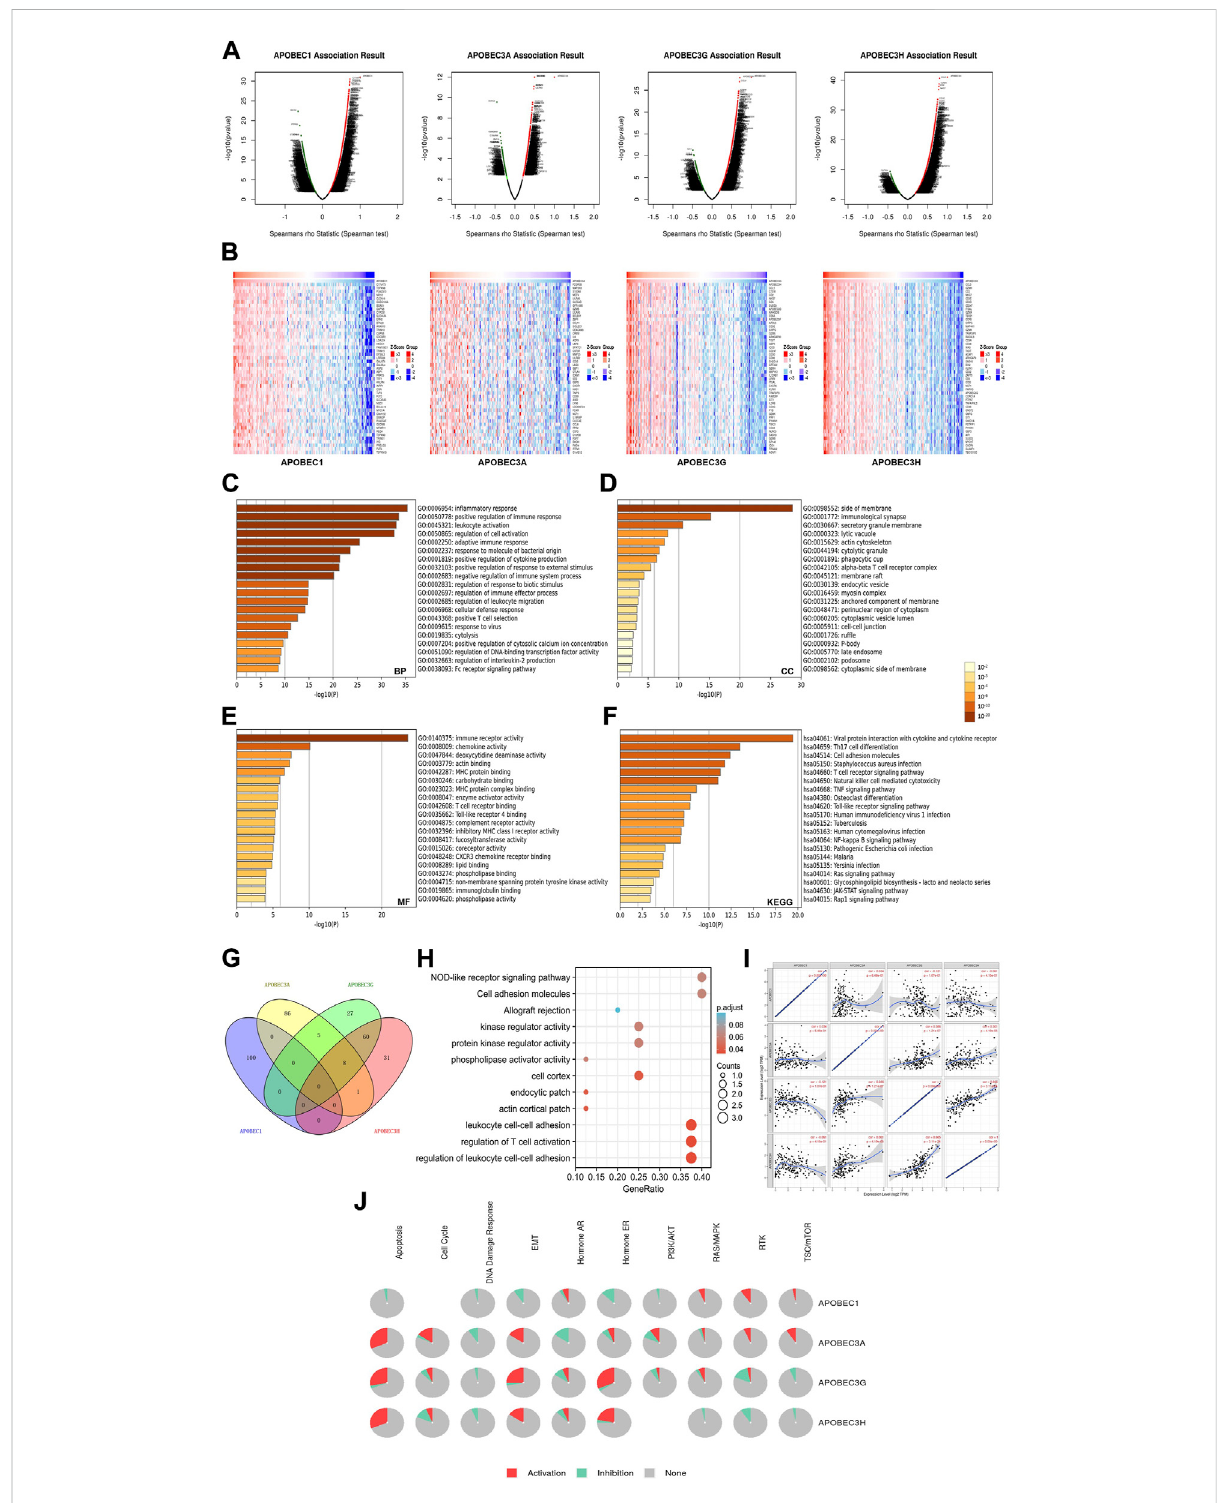
FIGURE 5 GeneenrichmentanalysisoftheAPOBECfamilymembersAPOBEC1,APOBEC3A,APOBEC3GandAPOBEC3HinPAAD. (A) Thevolcanoplotof APOBEC1/3A/3G/3H and their 400 coexpressed genes; (B) The top 50 genes positively correlated with APOBEC1/3A/3G/3H expression; (C – E) The GO enrichment of the BP terms, CC terms and MF terms of APOBEC1/3A/3G/3H and their 400 coexpressed genes; (F) The KEGG enrichment of APOBEC1/3A/3G/3Handtheir400coexpressedgenes; (G) ThevenndiagramofAPOBEC1/3A/3G/3Handtheir400coexpressedgenes; (H) GO and KEGG enrichment analysis of 8 genes co-expressed with APOBEC3A, APOBEC3G and APOBEC3H; (I) APOBEC1 was negatively correlated with the expression levels of APOBEC3G and APOBEC3H; (J) APOBEC1/3A/3G/3H played an activating role in a variety of oncogenic